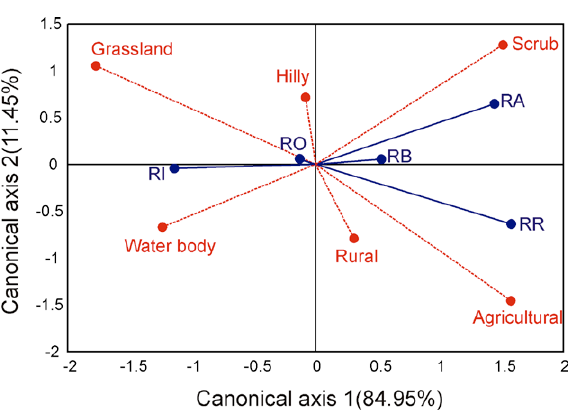
Figure 2. Redundancy analysis (RDA) depicting the canonical correlations between relative abundance of prey and habitat types. Percentage in parenthesis is the percentage variation explained by each canonical axis.